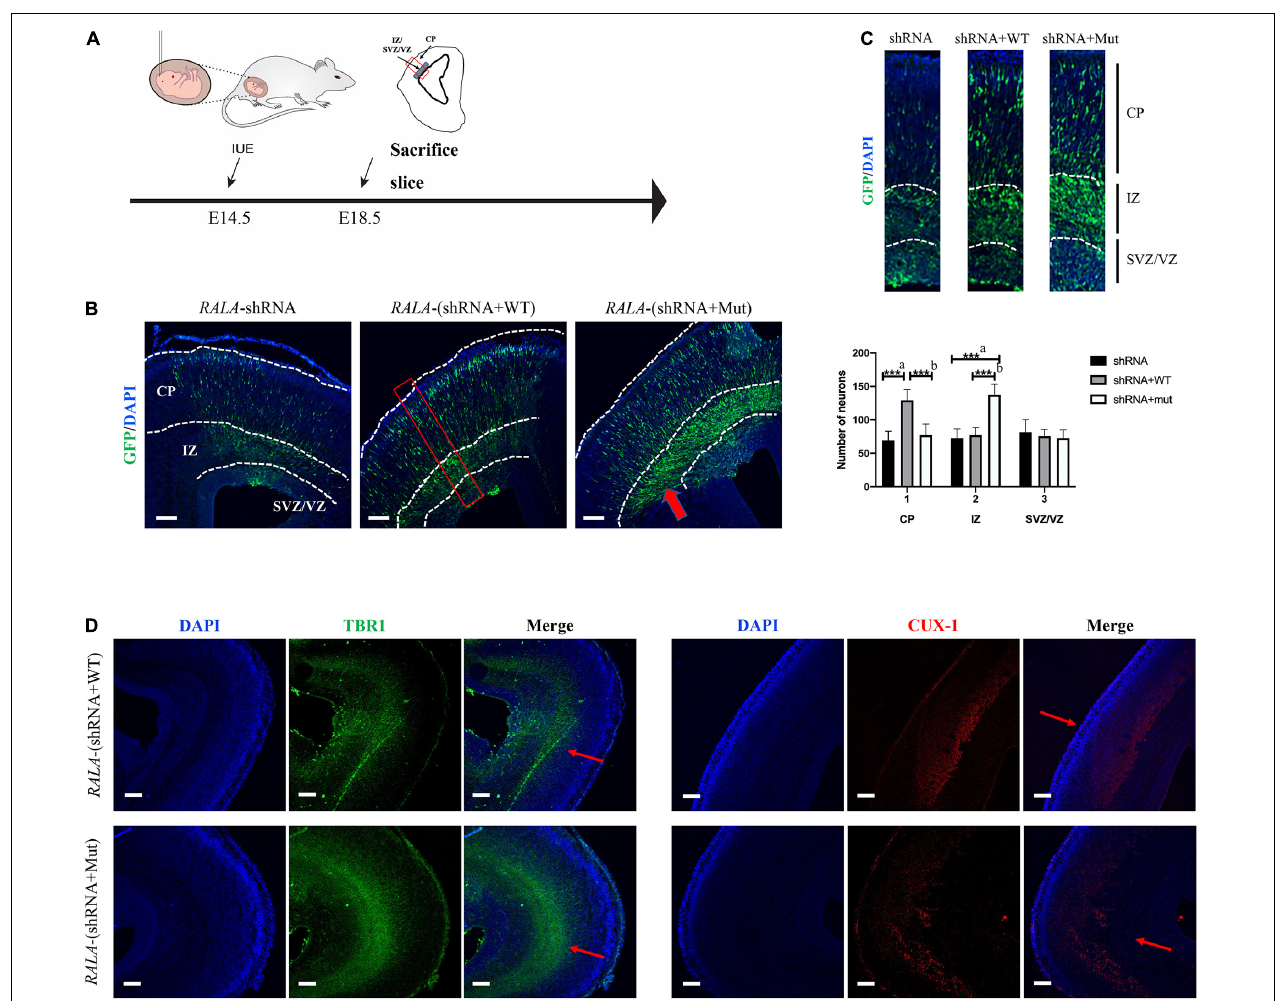
FIGURE 5 | Simulation of cortical dysplasia in mouse models via in utero electroporation. (A) Schematic diagram of animal experiment. (B) RALA c.G482A causes disorders of cortical neuron migration, as indicated by the thick red arrow. (C) Count and statistics of neurons in different areas of mouse cortex. Local amplification figure from the red square area. (D) Immunofluorescence labeled layer II/III/IV and layer V/VI neurons, thin red arrows. IUE, in utero electroporation; E14.5, embryo 14.5 days; VZ, ventricular zone; SVZ, subventricular zone; IZ, intermediate zone; CP, cortical plate; EEG, Electroencephalogram; shRNA, short hairpin RNA; TBR1, T-box brain transcription factor 1; CUX-1, Cut Like Homeobox 1. a, compared with RALA -shRNA group; b, compared with RALA -(shRNA + WT) group. n = 6, *** P < 0.001. Bar = 10 µ m; magnification: 10 ×